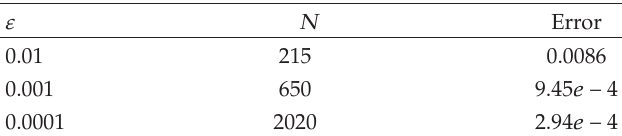
Table 2: Case h (cid:8) 0 .